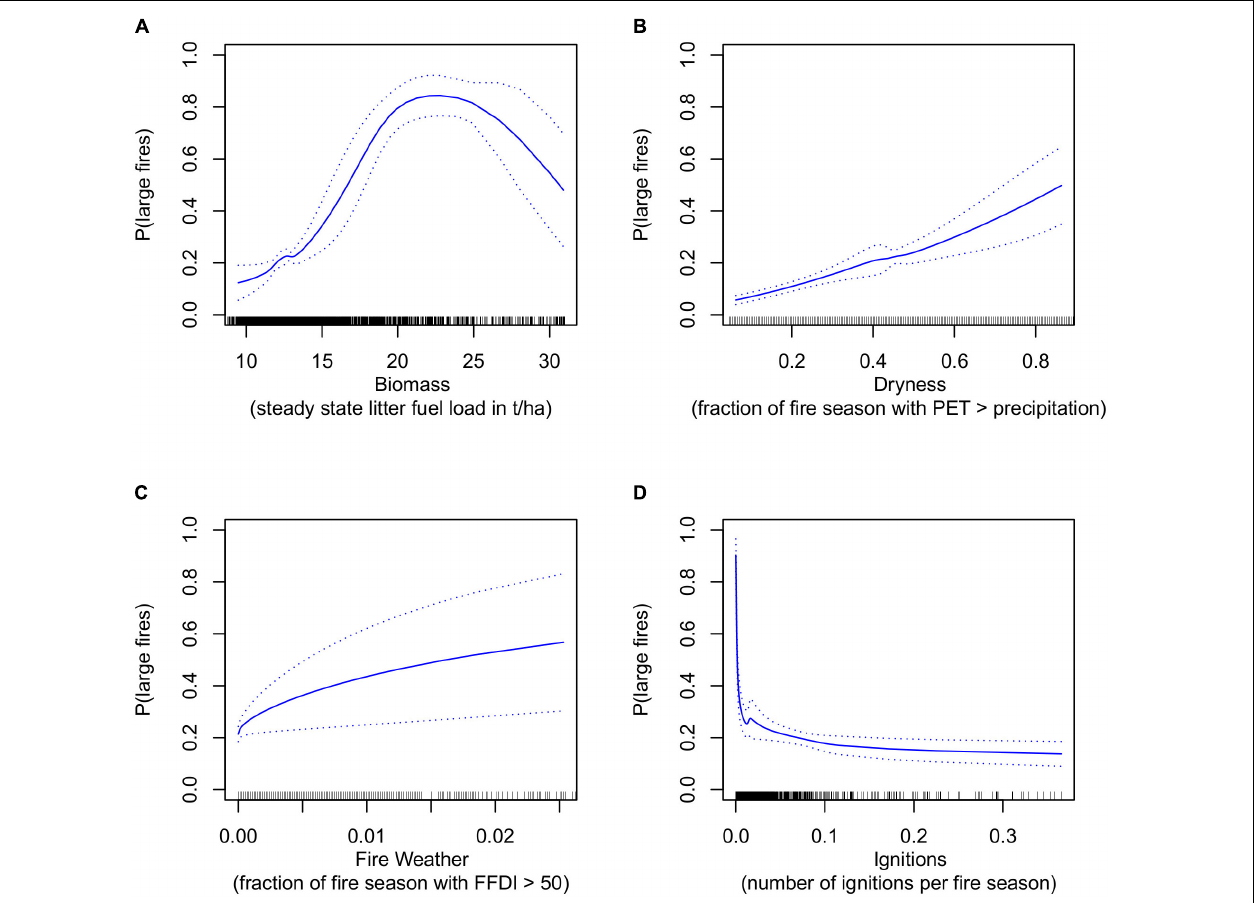
FIGURE 2 | Predicted response of large fire probability (1975–2014) in forests to each of the four major determinants of fire: biomass (A) , dryness (B) , fire weather (C) , and ignitions (D) . X-axis units are: (A) steady state litter fuel load in t ha − 1 ; (B) proportion of the fire season where PET > precipitation; (C) proportion of the fire season where FFDI > 50; (D) number of ignitions per fire season. Dotted lines show 95% confidence